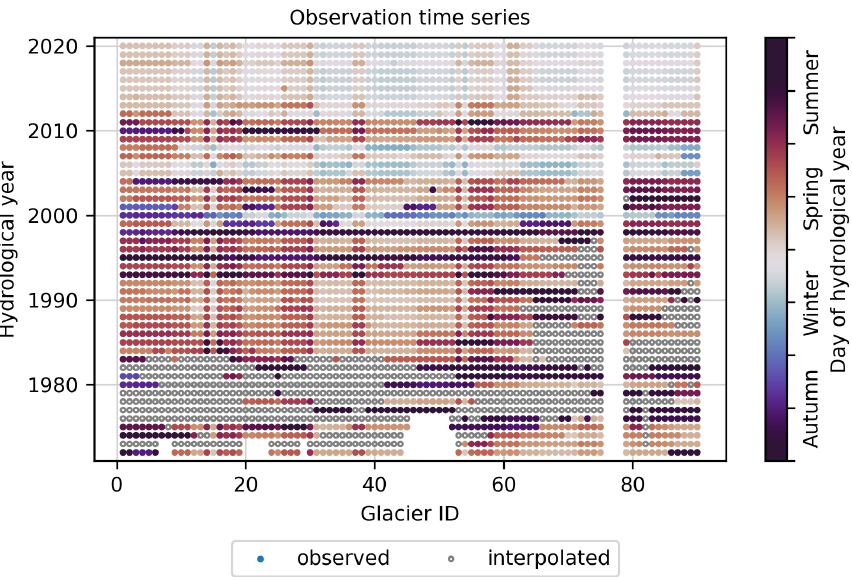
Figure 2. Years in which a terminus position was observed (filled circles) for each glacier, colored by the season of the observation. If a terminus position was not observed, an estimated position was interpolated (open circles) from prior and subsequent observations to use in annual analyses. Glacier nos. 76–78 are not shown because they are not ice-sheet outlet glaciers and therefore are not included in this